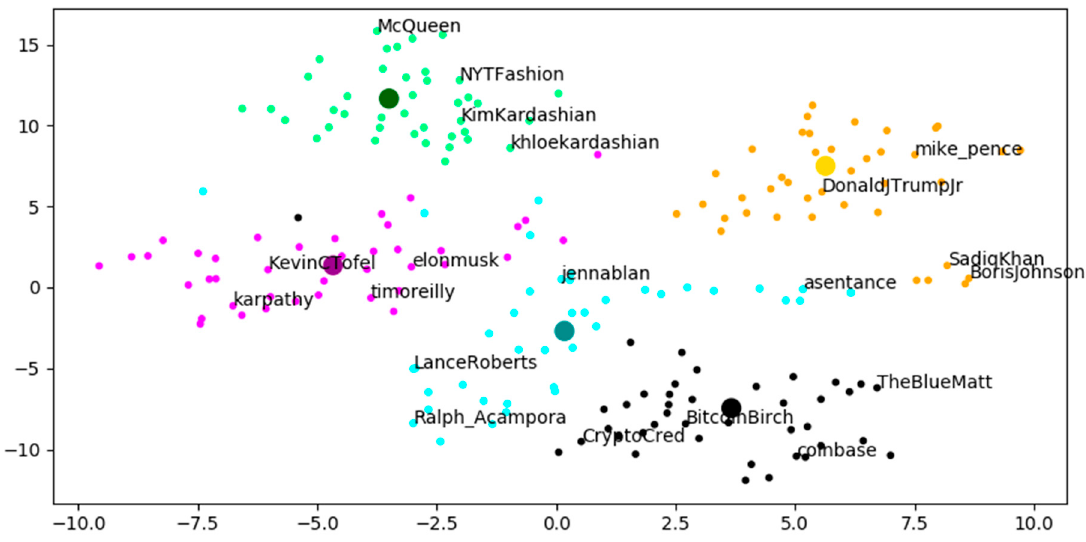
Figure 3. 2d view of the best model (accuracy 97.5%).